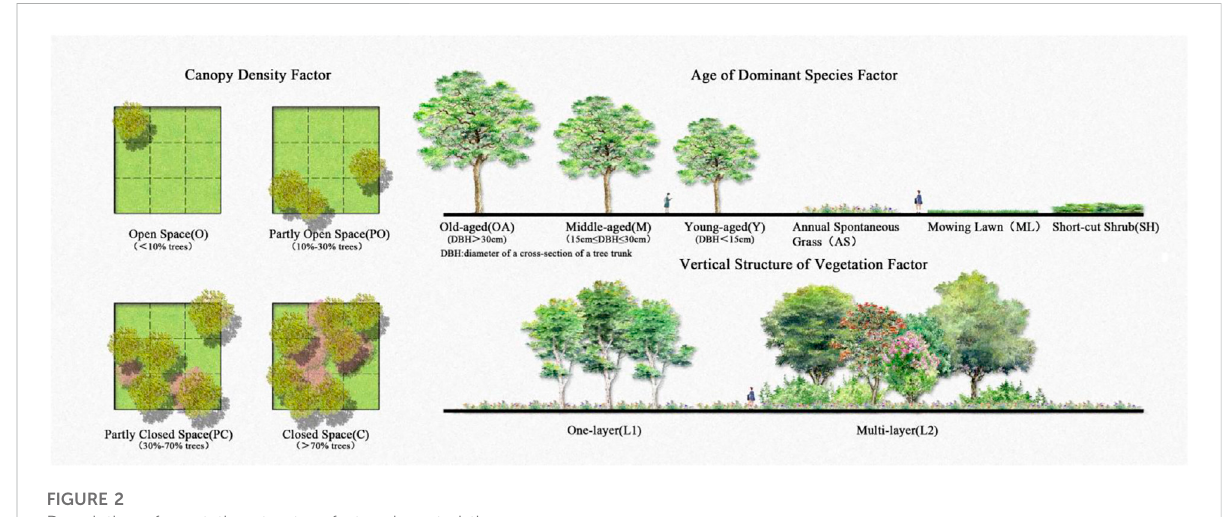
FIGURE 2 Description of vegetation structure factor characteristics.